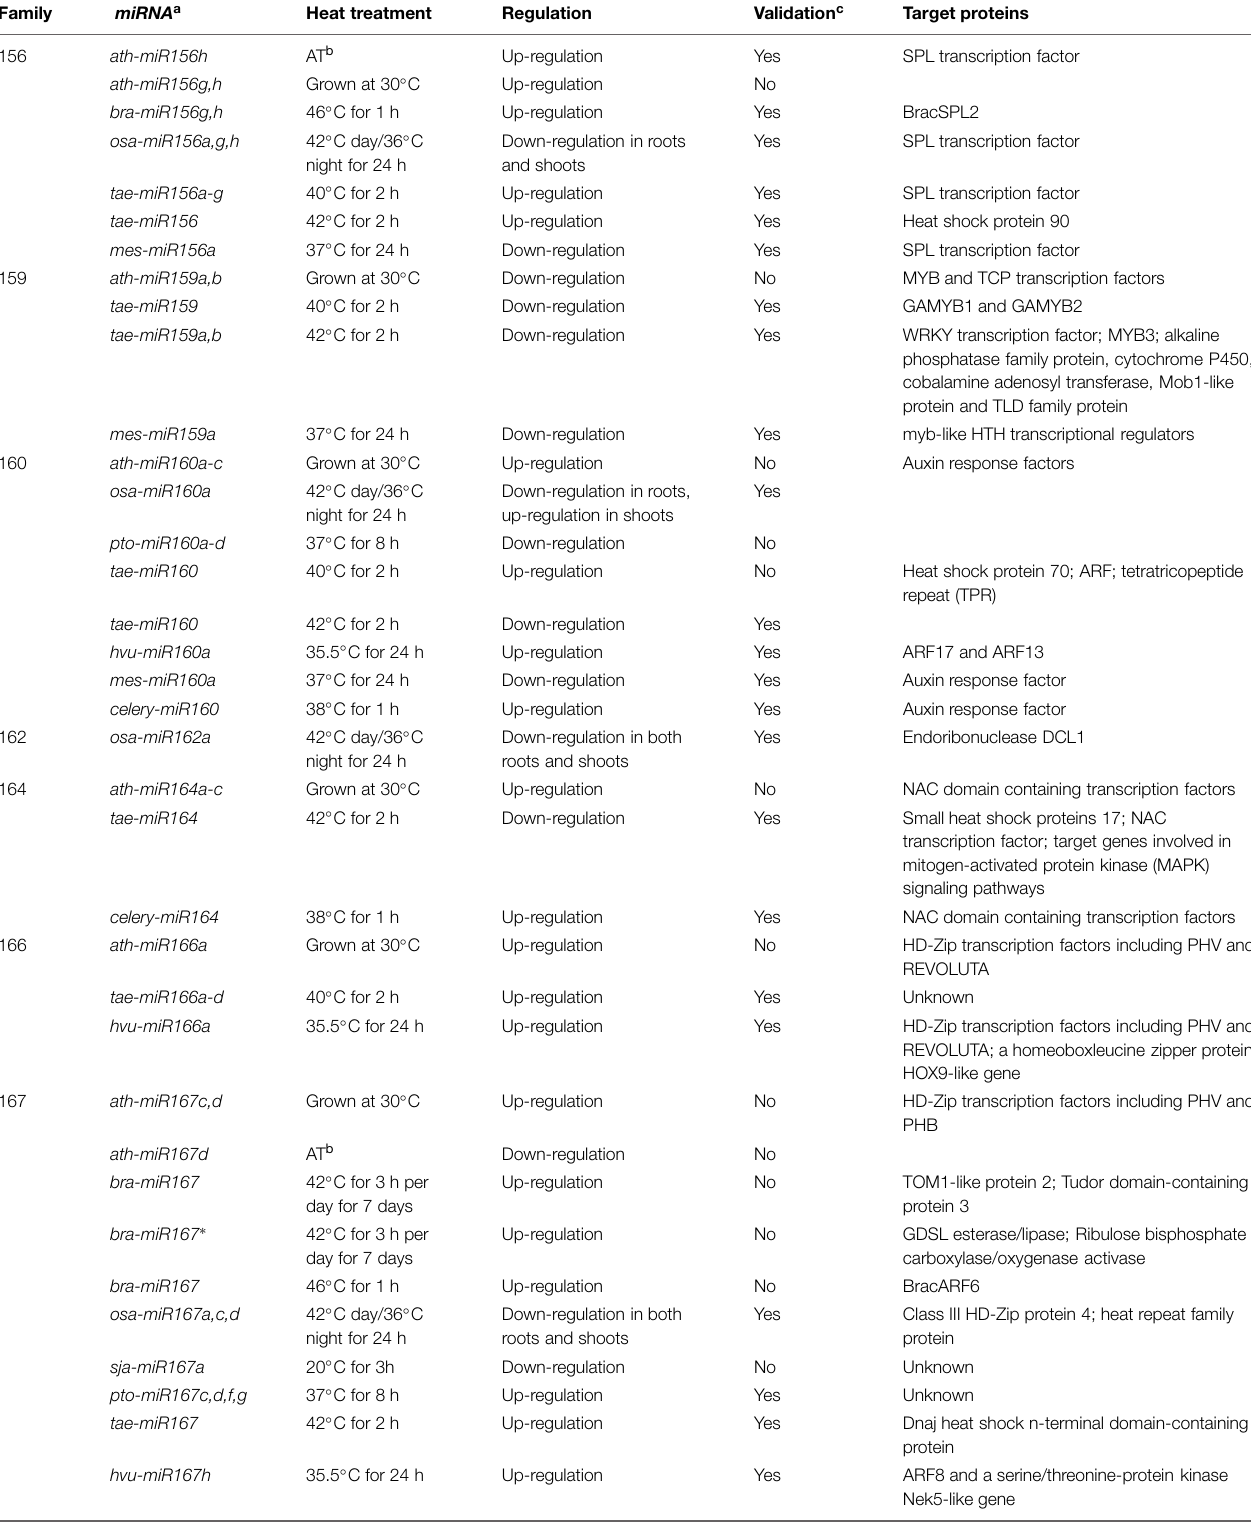
TABLE 2 | The conserved heat-responsive miRNAs in different plant